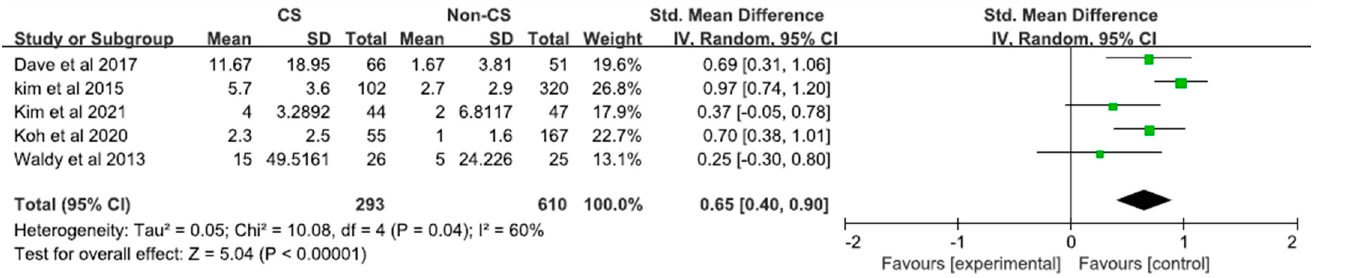
Figure 2. Forest plot of the relationship between CS and postoperative pain after TKA [29–32,35].